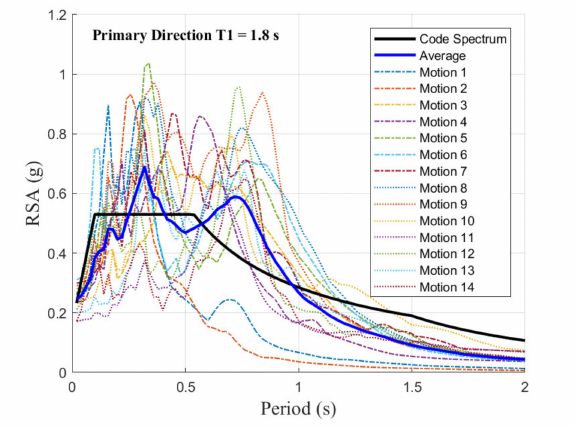
Figure 9. Case Study Output—site-specific acceleration response spectra in the primary direction when the fundamental period of structure is 1.8